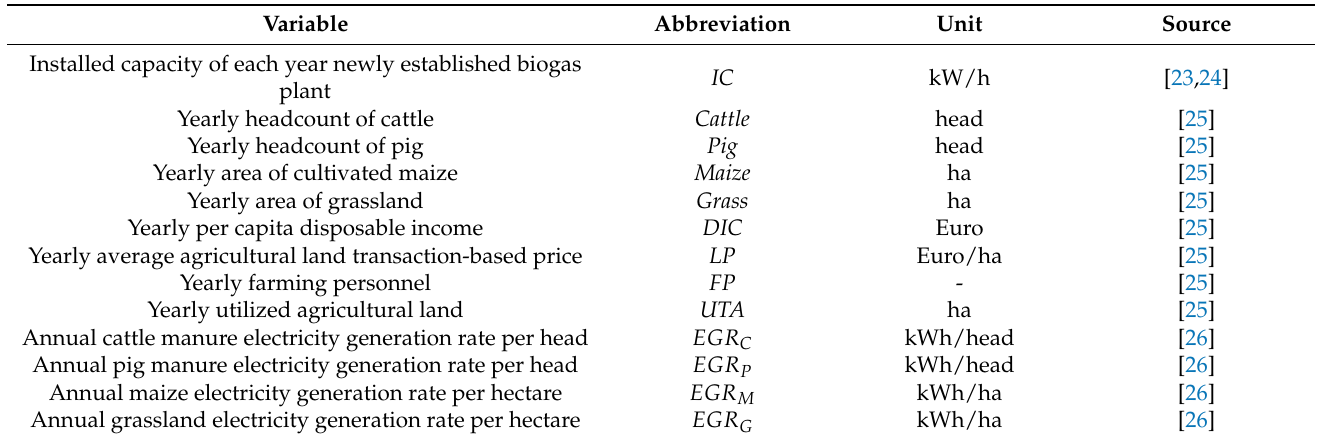
Table 1. Description of collected data used in statistical analysis.